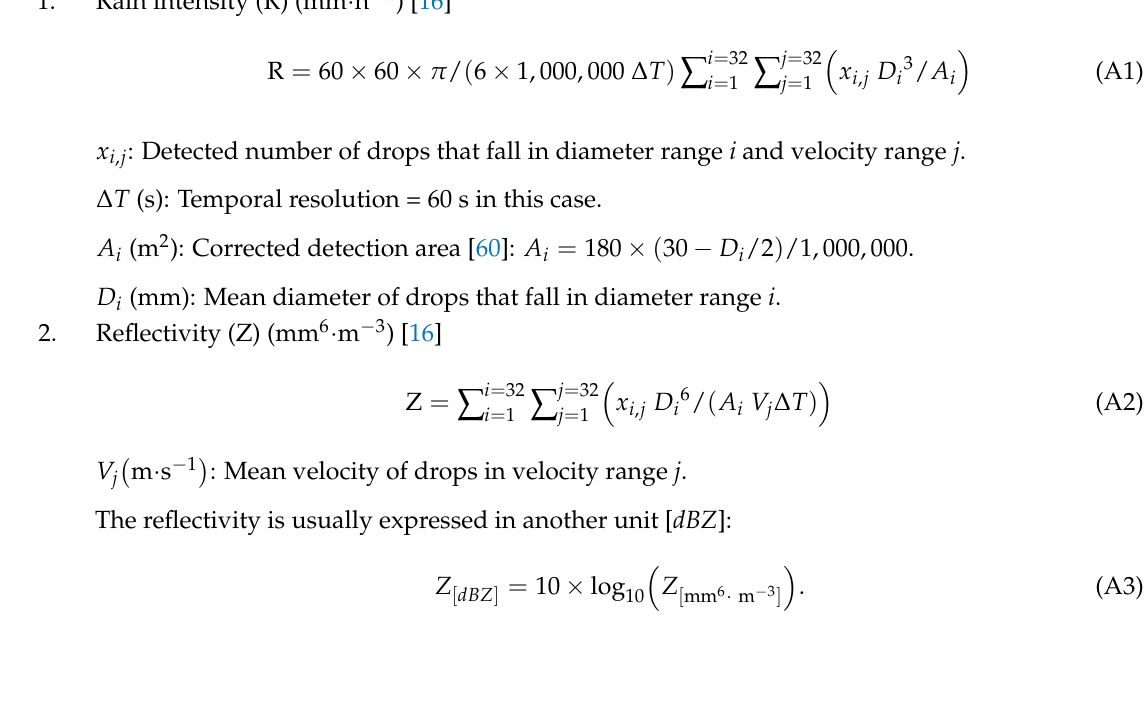
Table S1: “Accumulated rain duration and rain amount per disdrometer”, Figure S1: “Normalized rain DSD for a selection of GWLs in stratiform rain”, Figure S2: “Normalized rain DSD for a selection of GWLs in Convective